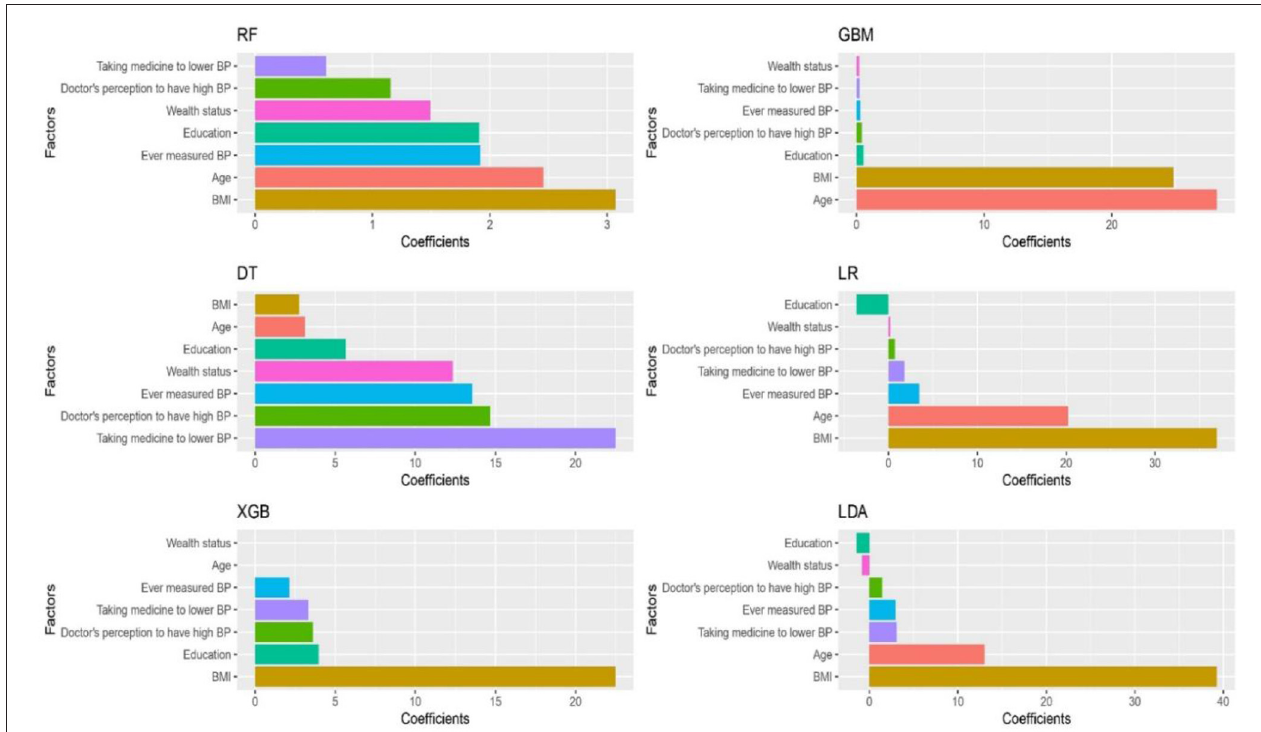
FIGURE 2 | Significant features for hypertension in three South Asian